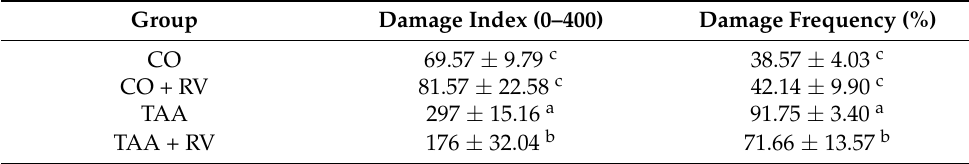
Table 1. Comet assay of the blood of rats with experimental severe acute liver failure and treated with resveratrol and ε -viniferin. Values are expressed as the mean ± standard deviation. Lowercase letters indicate significant differences between treatments ( p < 0.05), n = 100 for each animal (7 animals per group). Co: control; RV: resveratrol + ε -viniferin; TAA: